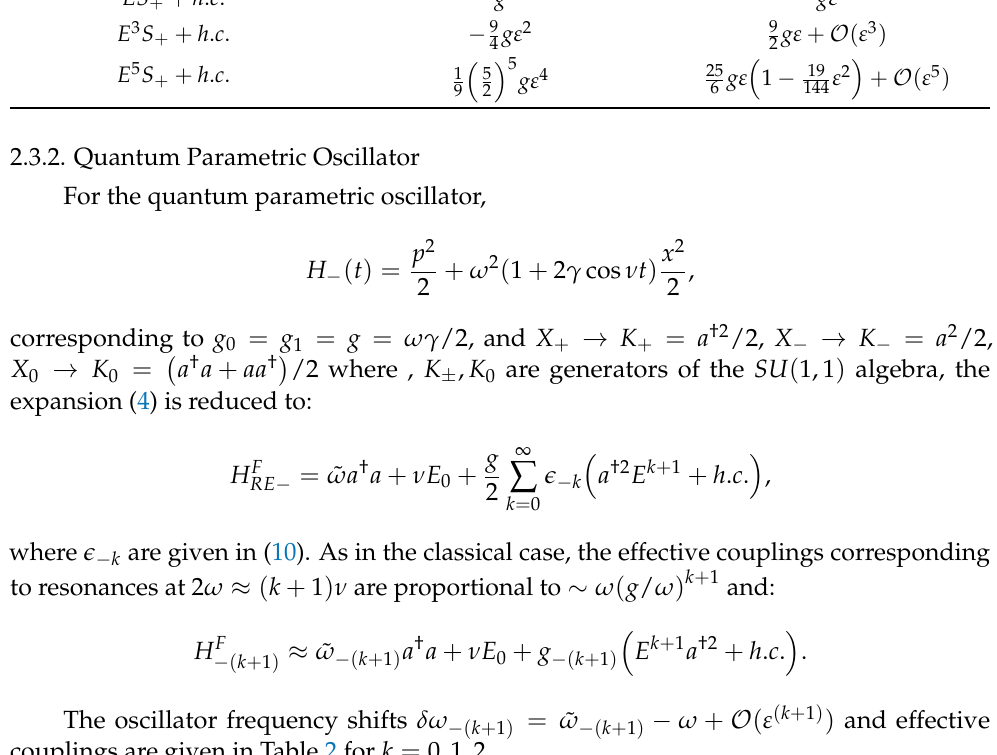
Table 1. The frequency shifts δω +( 2 k + 1 ) = ˜ ω +( 2 k + 1 ) g +( 2 k + 1 ) , k = 0,1,2 for the semiclassical Rabi model in terms of the small parameter ε = g / ω . Interactions g ef f